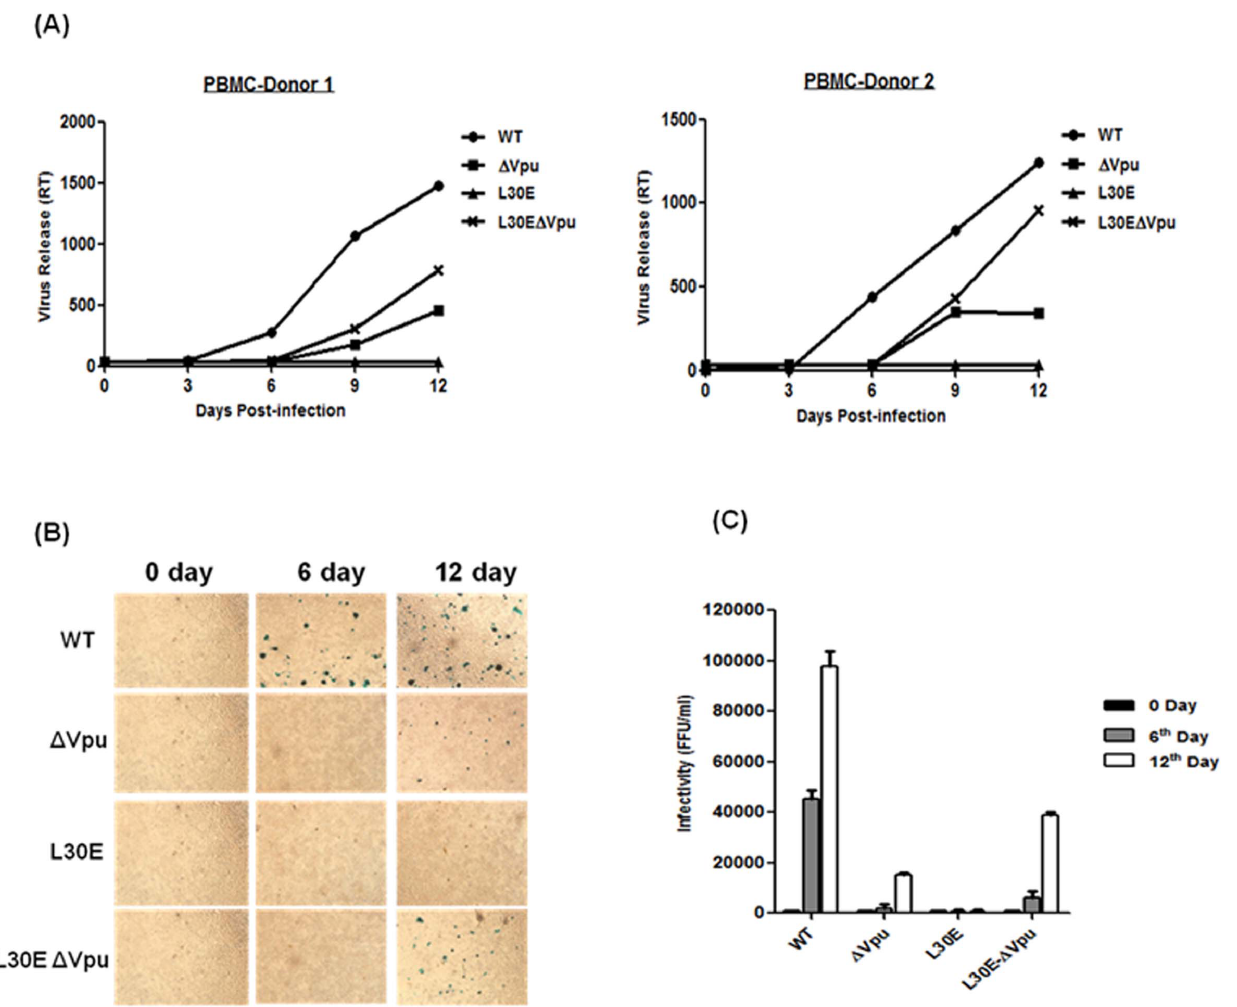
Figure 4. Virus propagation of Vpu and Gag L30E mutants in PBMC. Peripheral blood mononuclear cells (PBMC) were prepared from blood of healthy donors. The experiment was carried out in duplicate and in cells from two different donors and the results presented are averages of duplicate experiments. (A) PBMC obtained from two healthy seronegative donors were infected with equal focus-forming units (FFU) of WT and mutant ( D Vpu, L30E, L30E- D Vpu) viruses pseudotyped with VSV-G. The amount of virus release in the supernatant was monitored and assessed up to 12 days by RT-ELISA. Virus release from infected PBMC was plotted as RT activity versus number of days. (B) Viral supernatants harvested from infected PBMC were tested for infectivity in TZM-bl indicator cells. Equal amount of viral supernatant (50 m L) was added on TZM-bl cells in duplicates. At 48 h post-infection, TZM-bl cells were fixed and stained with X-Gal substrate for b -galactosidase activity to give blue FFU. Figure shown represents infectivity of viruses harvested at three different days (0, 6 th and 12 th day). (C) Blue cells were counted as infectious units and calculated as FFU per milliliter and plotted as graph.